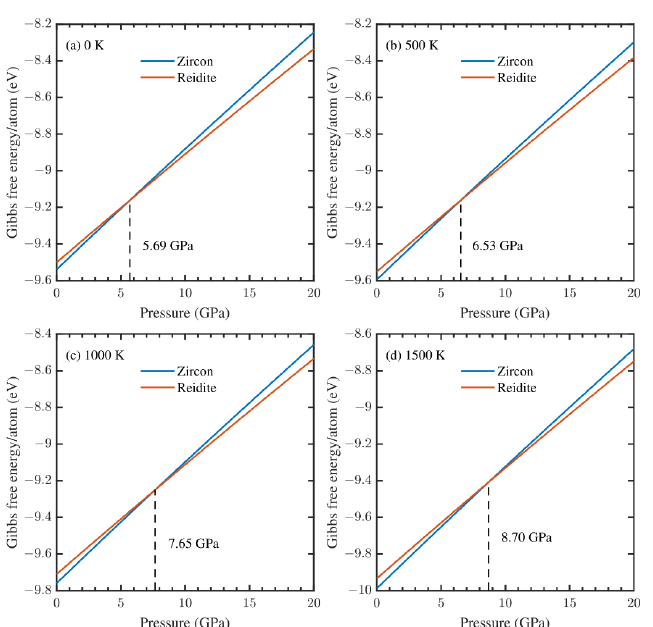
Figure 4. The characteristics of zircon Raman spectra at different pressures in ( a ) DD0162(1) and ( c ) DD0159. The red arrows represent the split of the peak containing the B 1g (1) and E g (2) modes. Raman shift of the zircon B 1g (1) and E g (2) modes at different pressures in ( b ) DD0162(1) and ( d ) DD0159. The dashed lines represent the second ‐ order polynomial fit to the data. The vertical dot ‐ dashed lines correspond to the abrupt change of d ω /dP of the E g (2) modes.